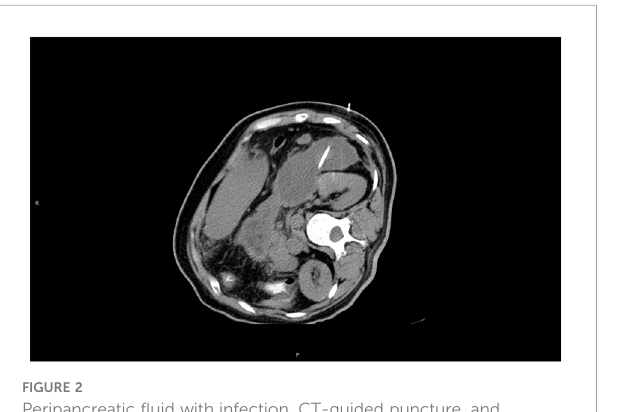
FIGURE 3 Loss of pancreatic contour, massive oozing from the head of the pancreas, and pancreatic